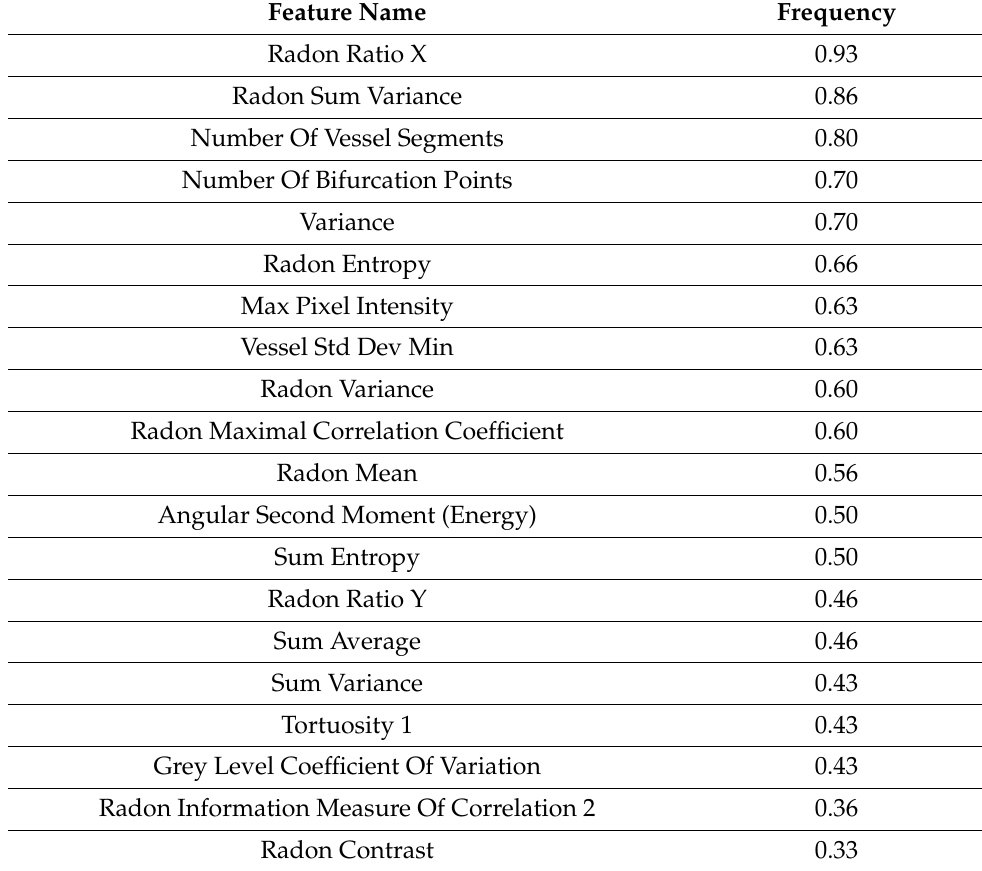
Table 2. Selected Features obtained from the proposed method based on UMDA and the SVM using the training set of X-ray